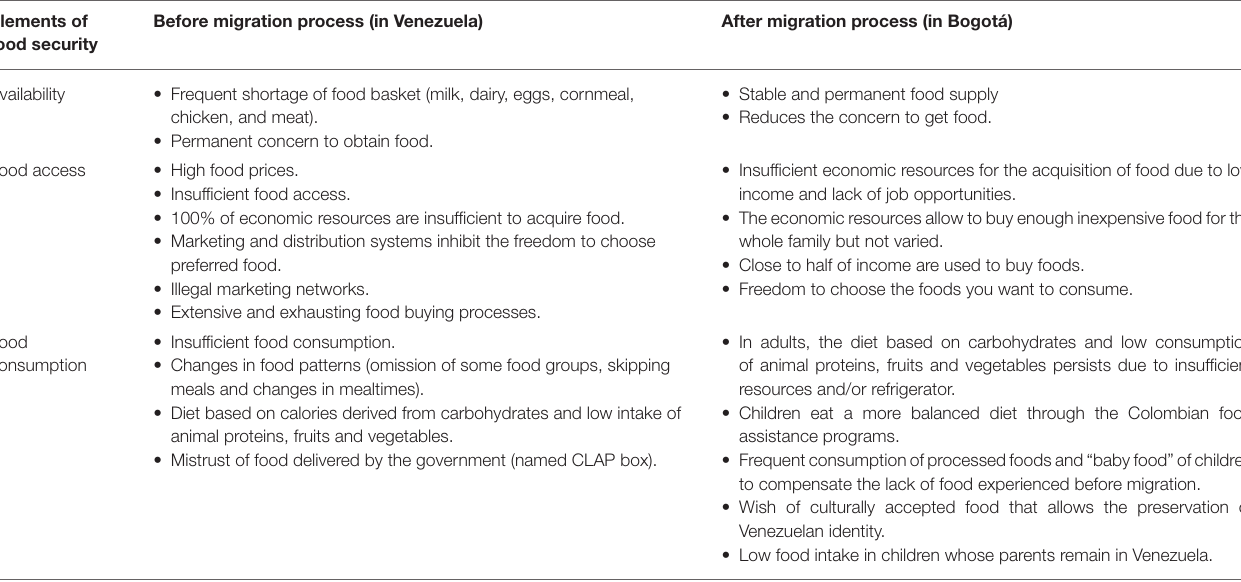
TABLE 2 | Elements of food insecurity in Venezuelans before and after the migration